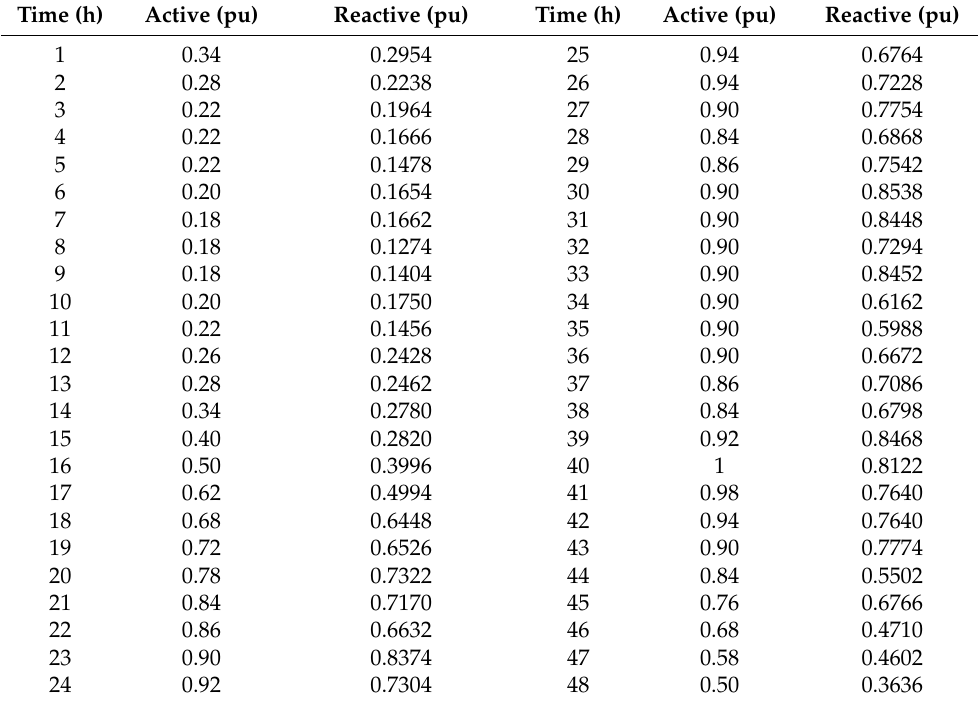
Table 7. Behavior of the daily active and reactive power